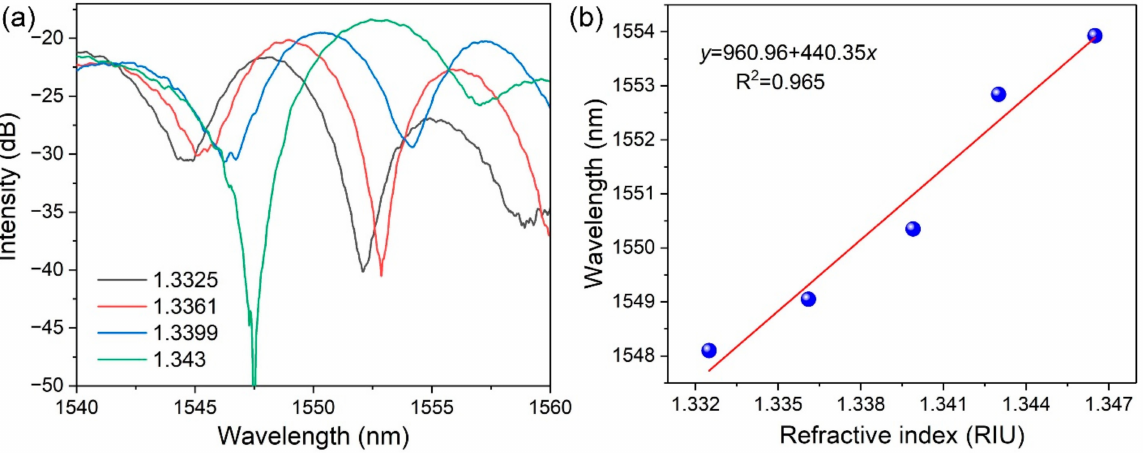
Figure 3. ( a ) Relationship between Bragg resonance wavelength and liquid RI. ( b ) The linear relation- ship of refractive index and resonance wavelength of the fully encircled µ -PFBG.